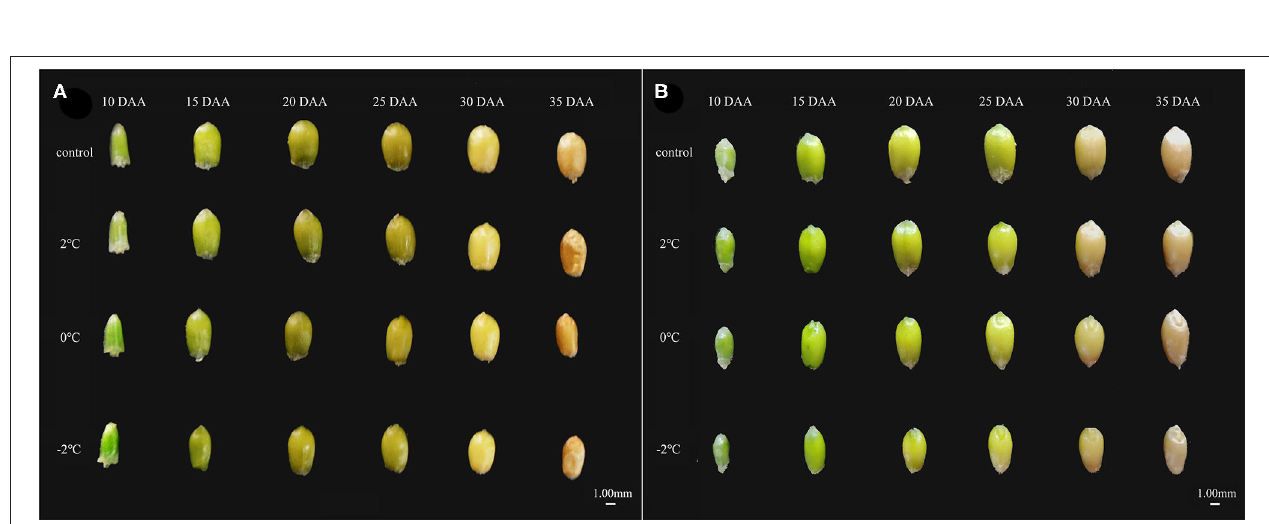
FIGURE 2 | The effects of short-term low temperature (LT) at the booting stage on the morphology of grains during the grain filling stage (DAA, day after anthesis). At the booting stage, the sensitive (Yangmai 18, A ) and the tolerant (Yannong 19, B ) varieties were placed in the artificial climate chamber for LT stress. The temperature was set to 5 ◦ C during 07:00–19:00 and at 2, 0, and − 2 ◦ C during 19:00–07:00. The normal growing plants without cold stress were used as controls.